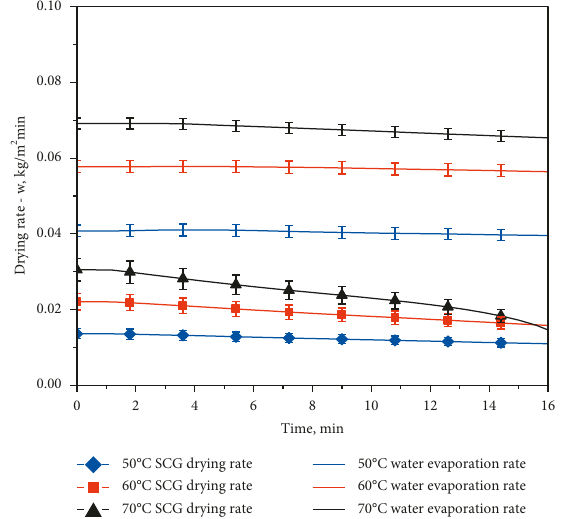
Figure 8: Comparison between the drying rate of spent coffee grounds and the water evaporation rate at a furnace air velocity of 0.003m/s and the following temperatures of 50, 60, and 70 ° C.